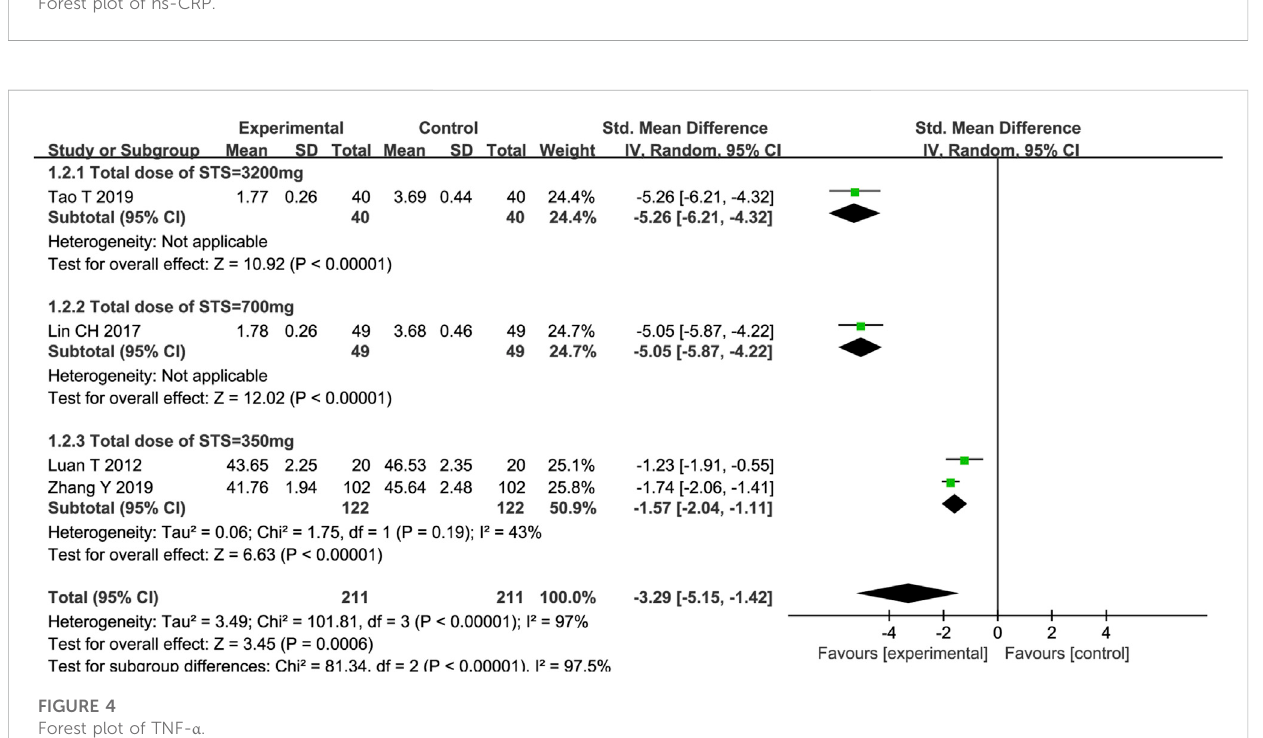
FIGURE 3 Forest plot of hs-CRP.